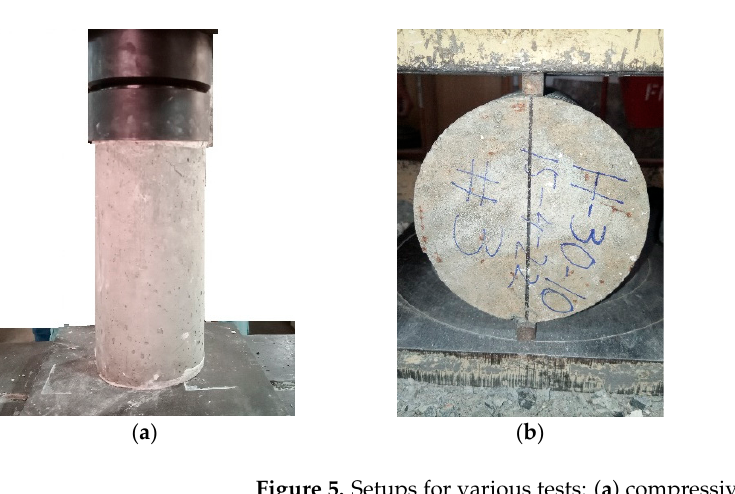
Figure 4. Pan ‐ type mixer used for mixing of concrete.